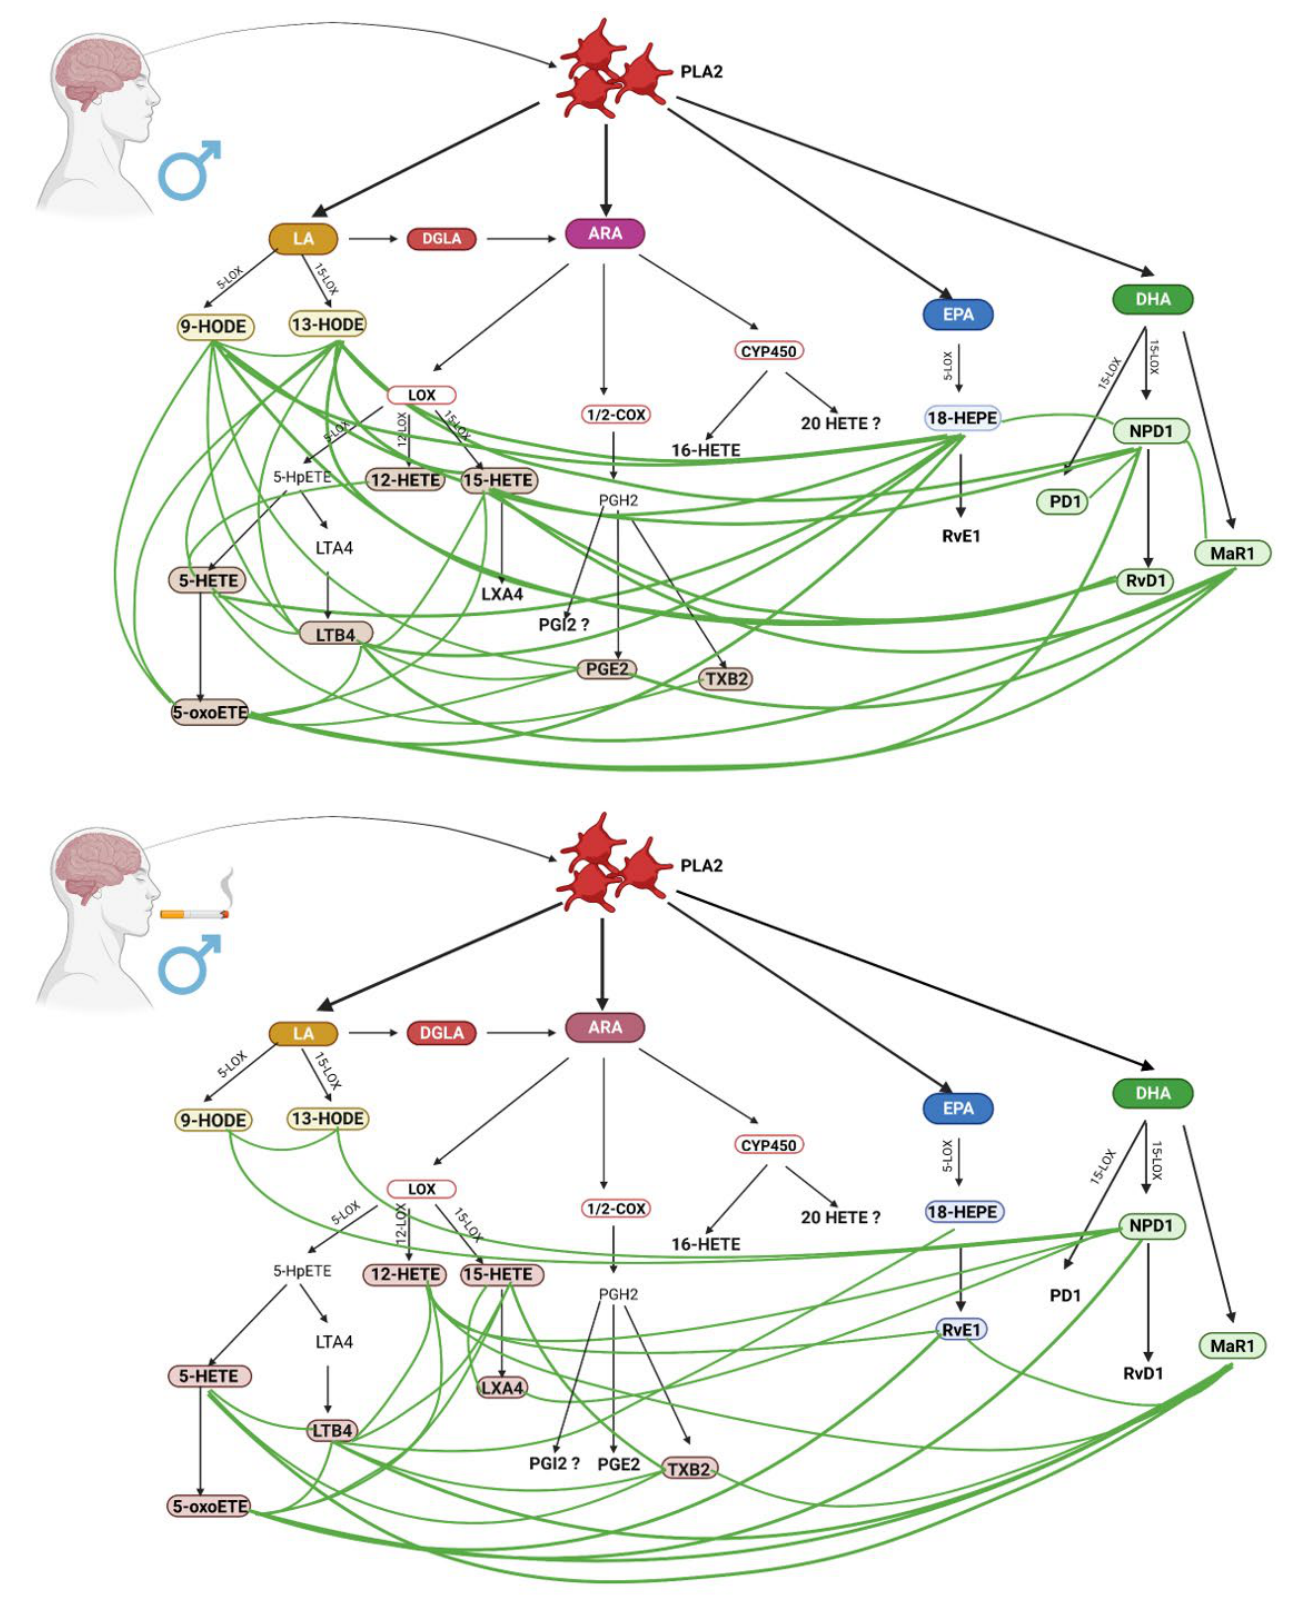
Figure 3. Comparison of inflammatory response in male non-smokers and male smokers. (Created with BioRender.com https://app.biorender.com/; accessed on 30 September 2022).